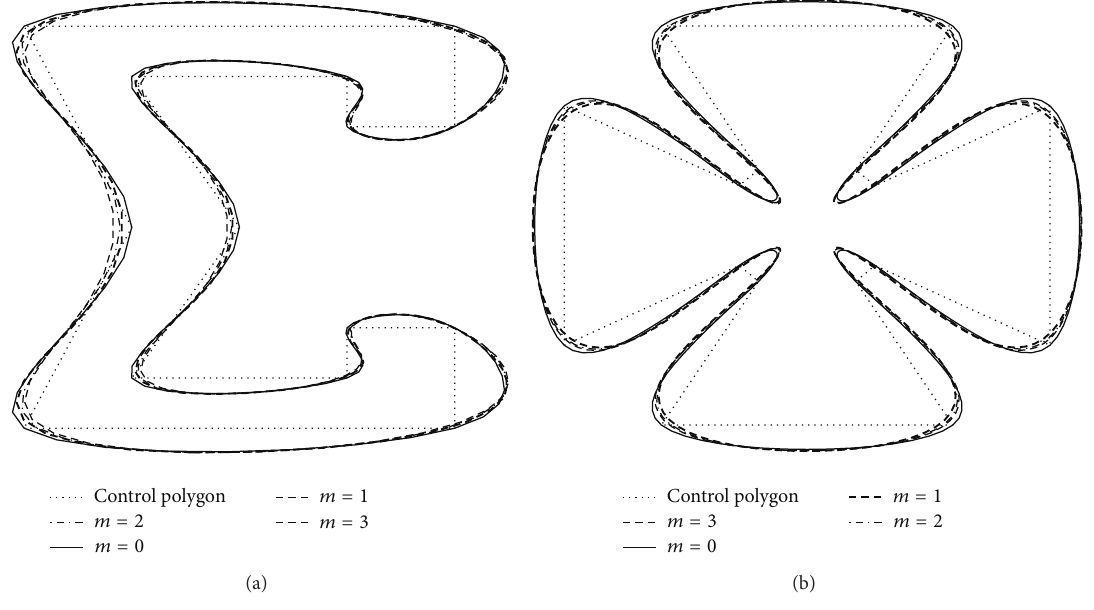
Figure 2: Limit curves generated by the 𝑞 -scheme by applying 0, 1, 2, and 3 smoothing stages.